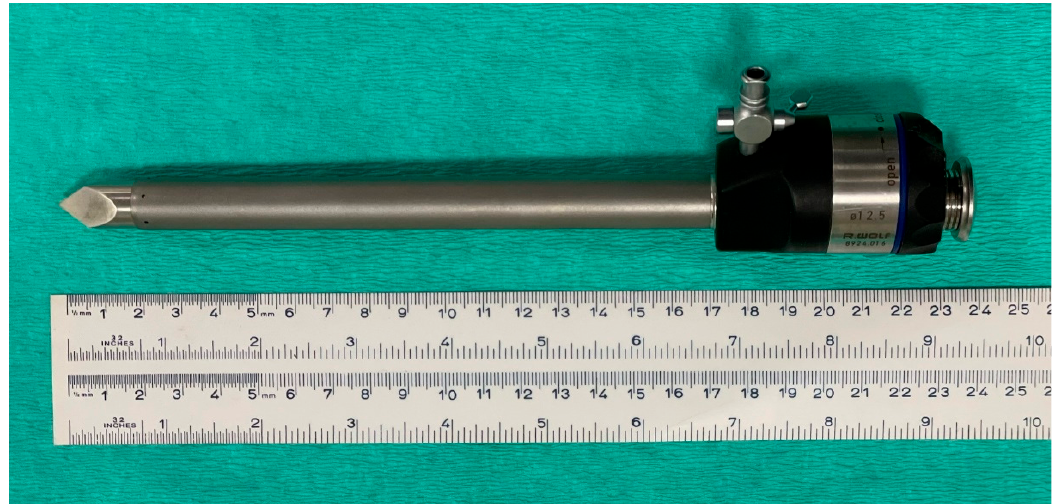
Figure 2. Device used in Group T. Laparoscopic cannula (12.5 mm diameter, 15 cm length) with a pyramidal tip trocar of 17 cm.